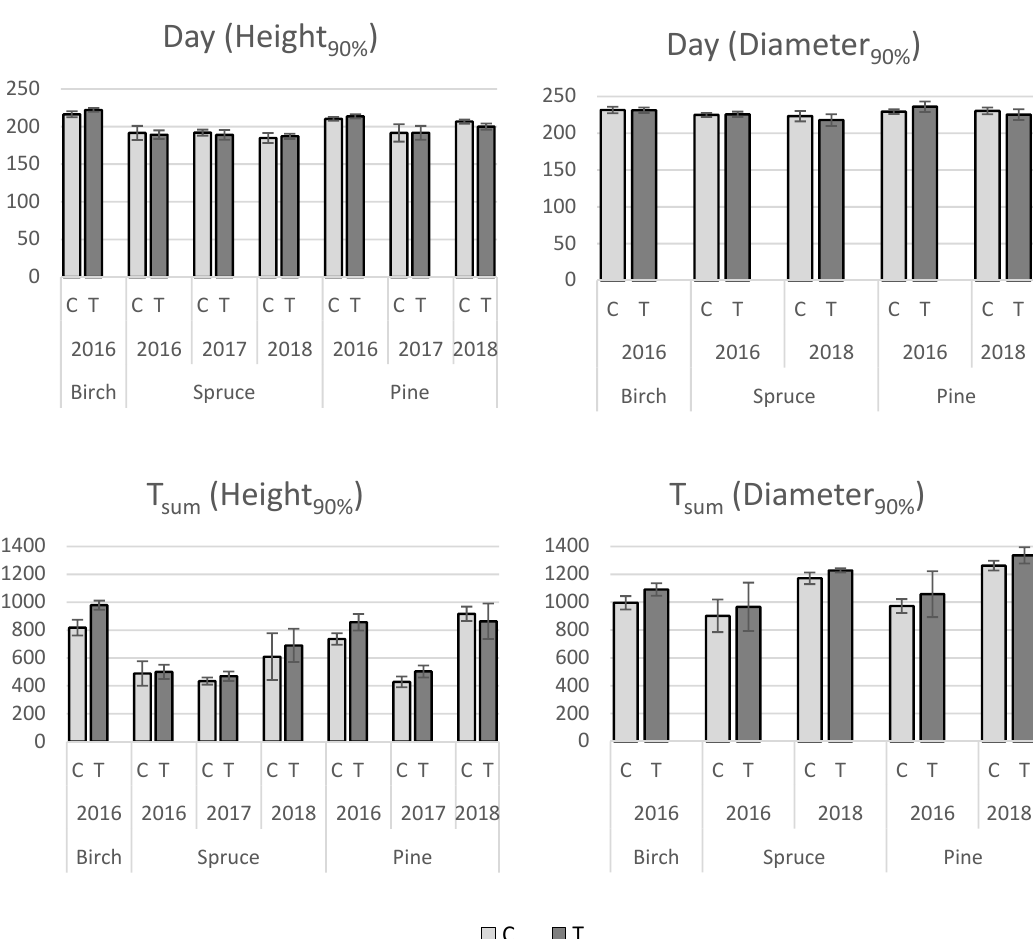
Figure 5. The average day (days from the beginning of the year) (±SD) and average T sum (±SD) on and at which 90% of the annual growth of height (left) and diameter (right) were reached in the silver birch, Norway spruce and Scots pine seedlings harvested in 2018 under warming treatment (T) and ambient (C) conditions.